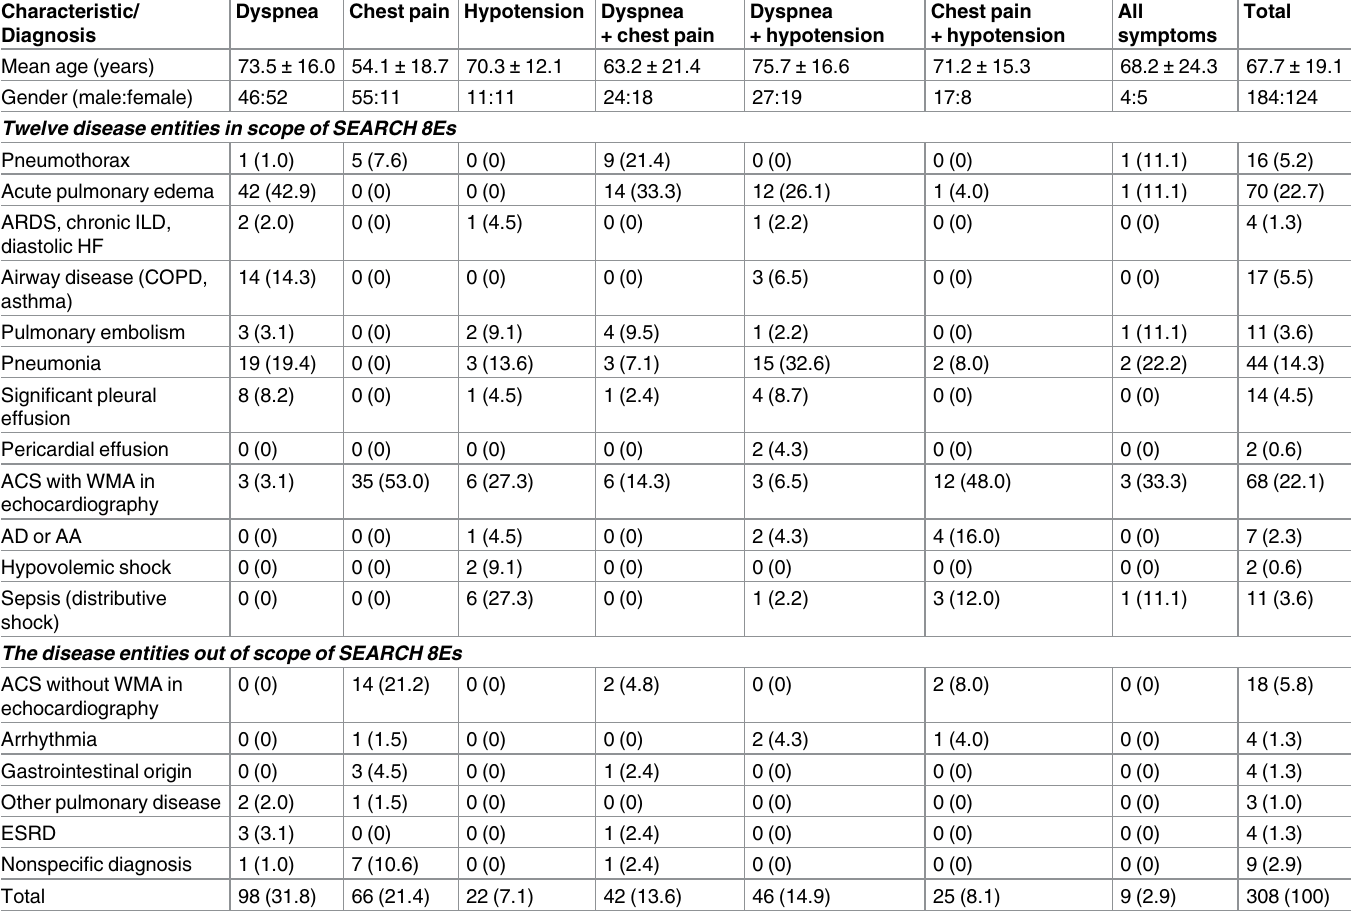
Table 3. General patient characteristics in terms of the symptoms and final diagnoses ( n ,